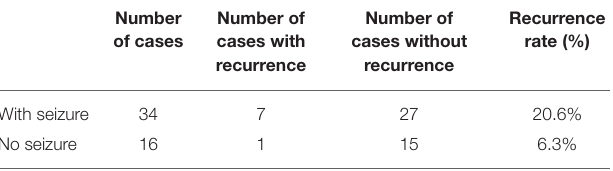
TABLE 3 | Relationship between recurrence and